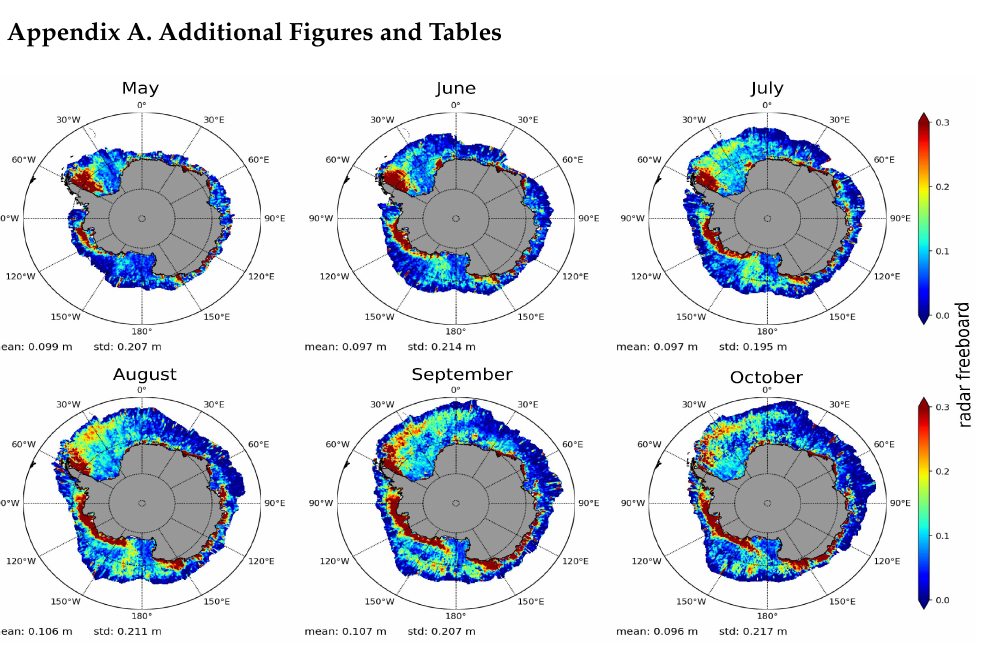
Figure A1. Monthly mean maps of CryoSat-2 radar freeboards in winter 2011. They are computed from the